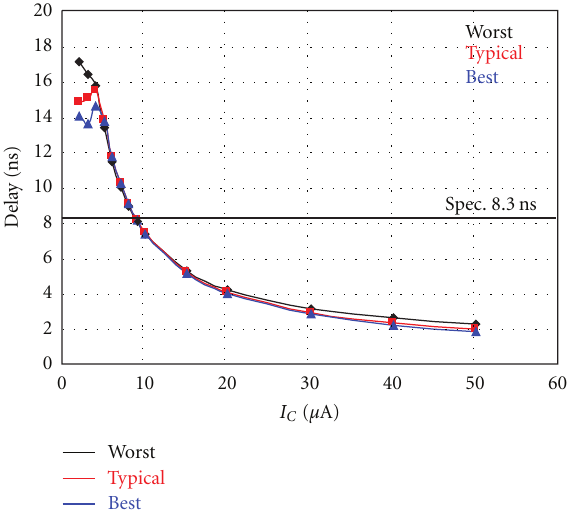
Figure 17: Postlayout simulation results of VCDL delay-current characteristics for DLL1.